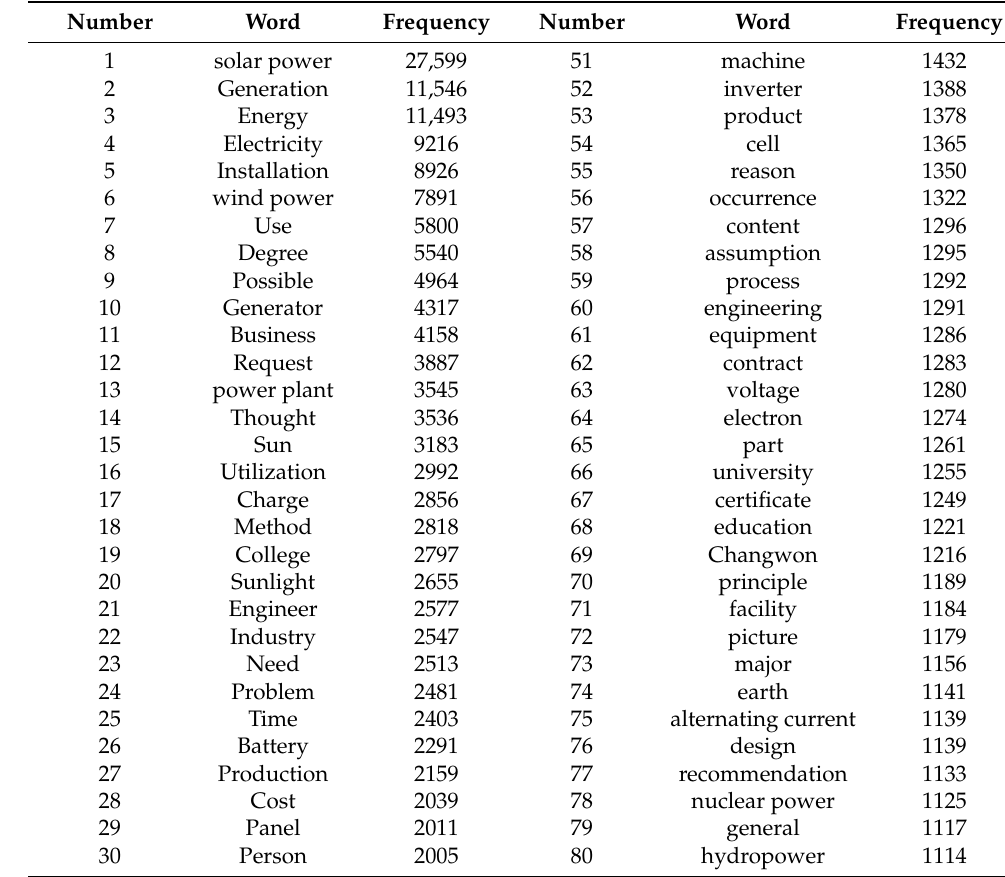
Figure 2. Number of questions about renewable energy by year. Table 2. List of the top 100 words most frequently appearing in